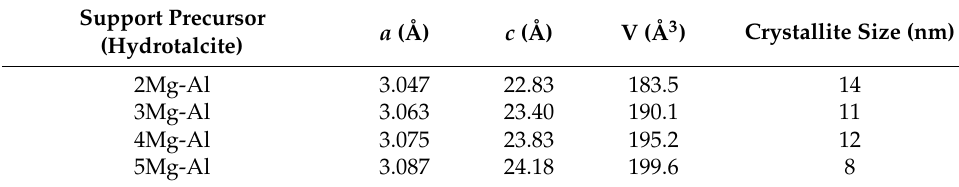
Figure 3. XRPD patterns of the ( a ) hydrotalcites (the reflections typical of a layered double hydroxide structure are marked) and ( b ) mixed oxides with various Mg/Al molar ratio: (1) 2Mg-Al, (2) 3Mg-Al, (3) 4Mg-Al, (4) 5Mg-Al. Table 2. Rietveld refinement structural data of the support precursors (hydrotalcites)